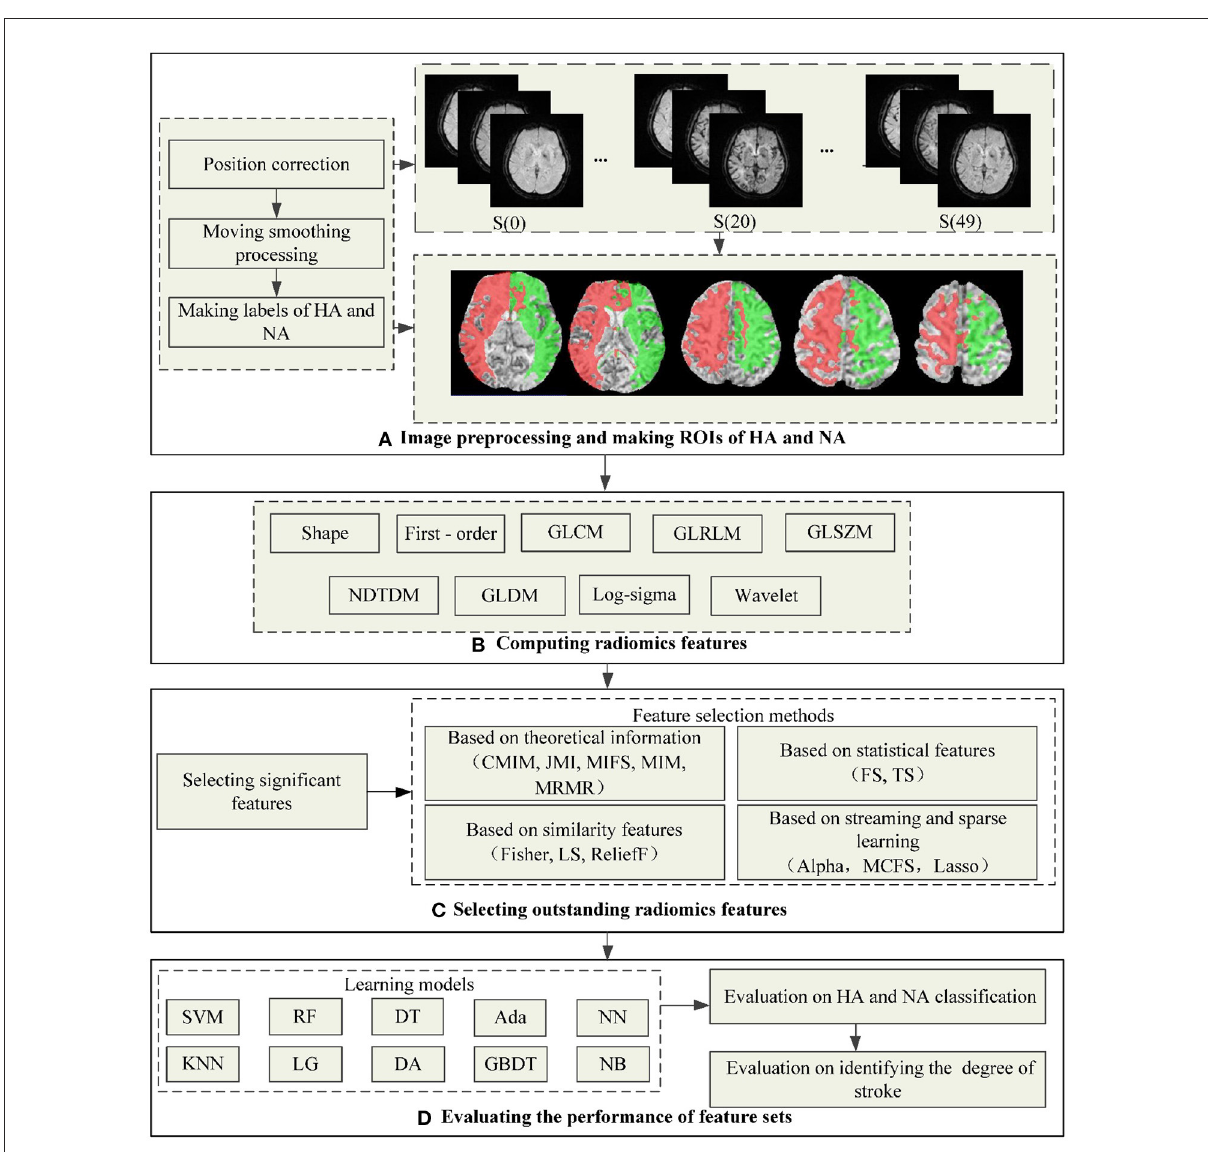
FIGURE1 The flowchart of the proposed method in this study. (A) Shows the process of preprocessing images and making ROIs of HA and NA, wherein the red area is HA and the green is NA. (B–D) Show the process of computing radiomics features, outstanding feature selection, and evaluating the performance of feature